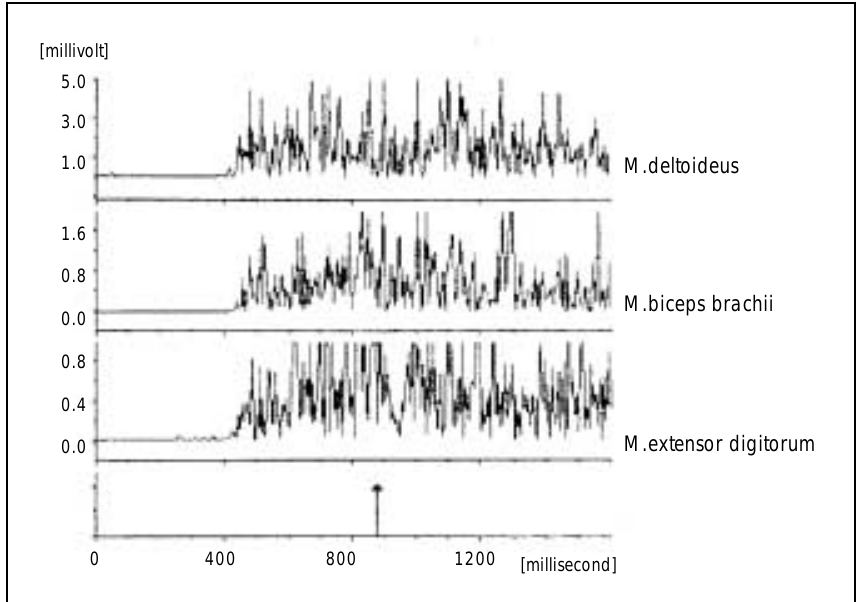
Figure 2: Electromyographic activity of the abduction movement of a healthy test